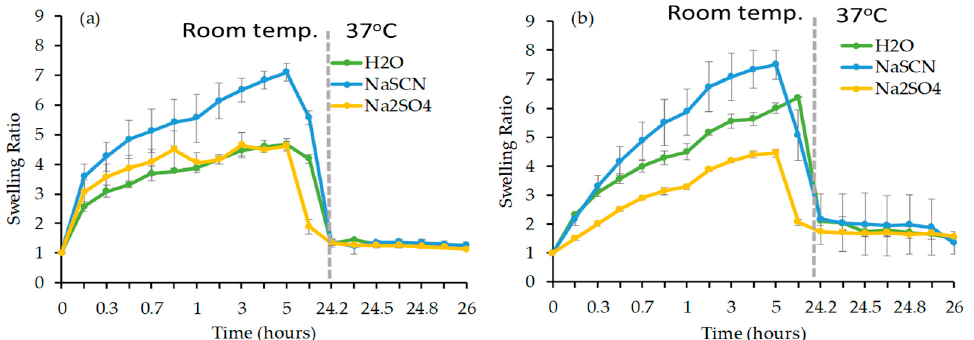
Figure 5. The SR as a function of time in deionized water, 0.1 M NaSCN and 0.1 M Na 2 SO 4 solution respectively at room temperature for the first 24 h and then 37 °C (shown as a grey line) for another 4 h for ( a ) G2F and ( b ) G2R gels.